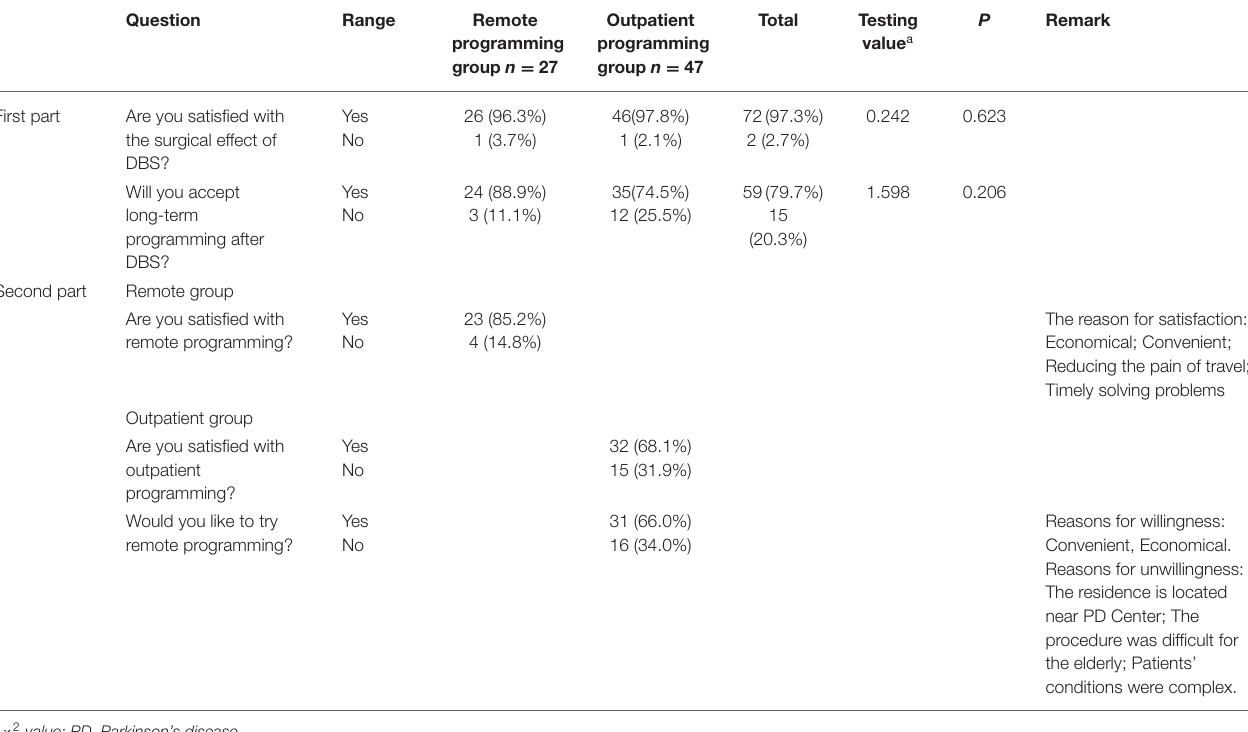
TABLE 2 | Satisfaction questionnaire results.